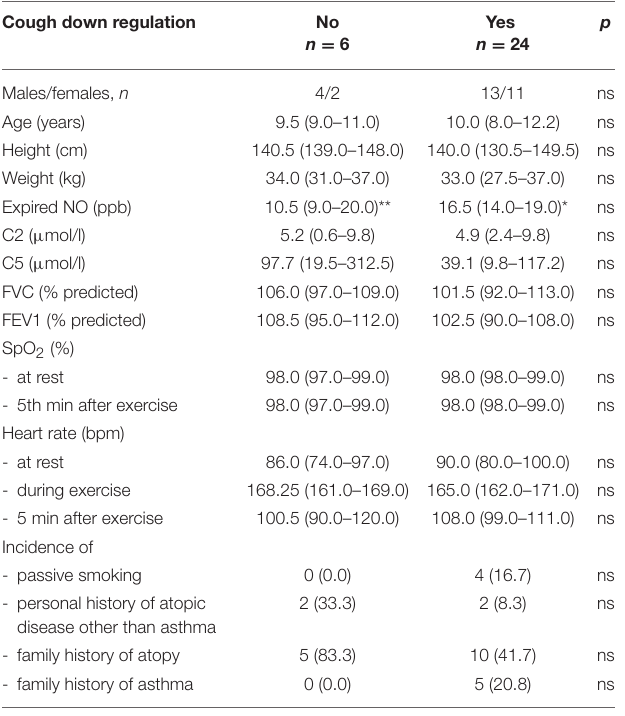
TABLE 2 | Characteristics of children with and without cough down regulation during